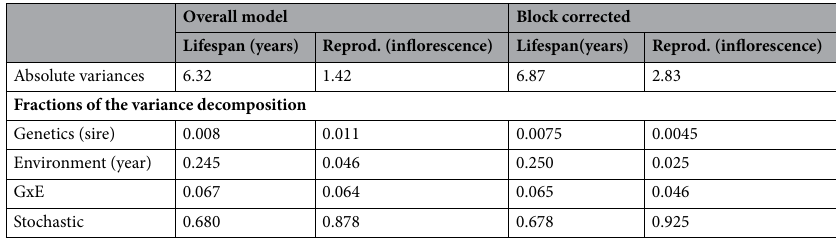
Table 1. Variance and the variance decomposition into genetics (sire), environment (variability among years), gene x environment interactions, and non-selective stochastic demographic variation for lifespan, and reproduction for two sets of models, (i) overall model without accounting for any spatial environmental variability, (ii) accounting for 17 blocks of the study